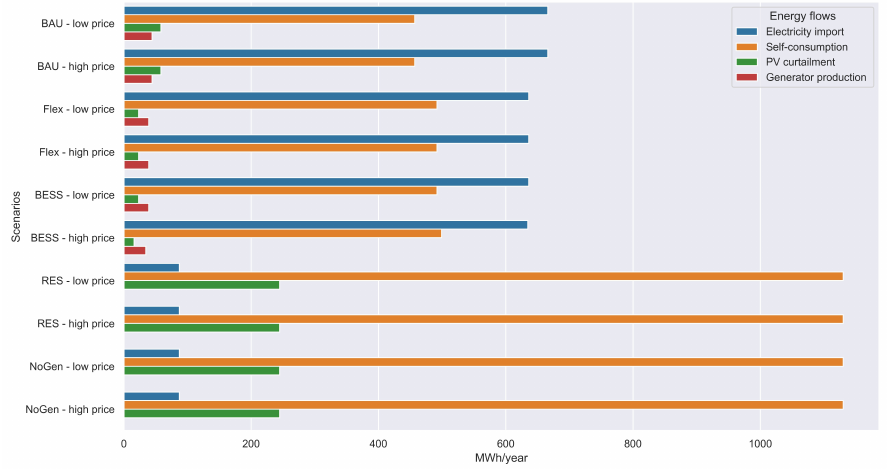
Figure 6. Yearly details on the composition of energy consumption for all scenarios.